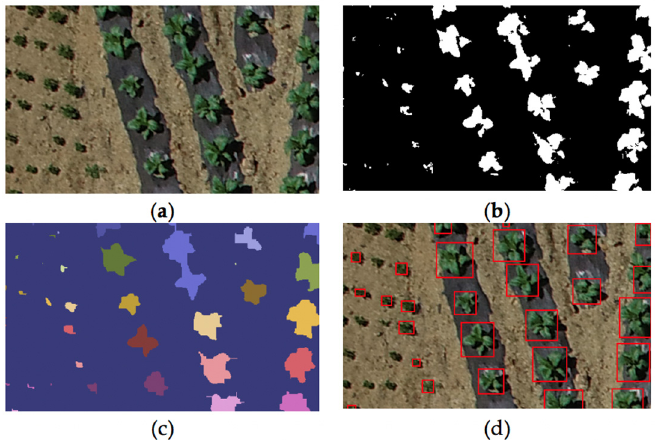
Figure 3. Process of candidate selecting algorithm. ( a ) The algorithm takes in an input, ( b ) binarizes the input by color, ( c ) groups the binary image, and ( d ) extracts the regions in the original image.